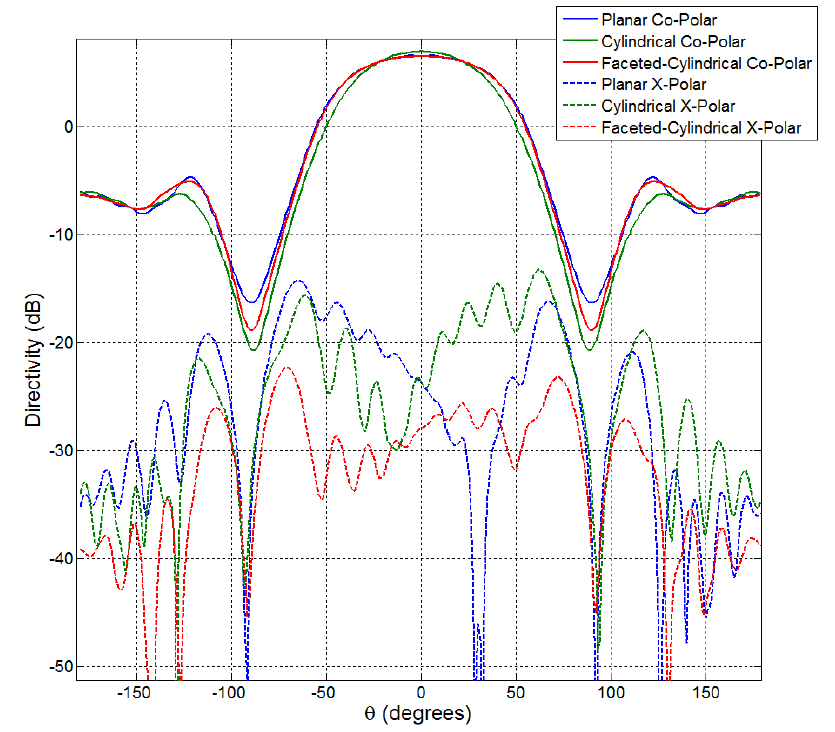
Figure 7. Simulation of an AEP of planar, cylindrical (100 λ radius) and faceted-cylindrical (100 λ radius)